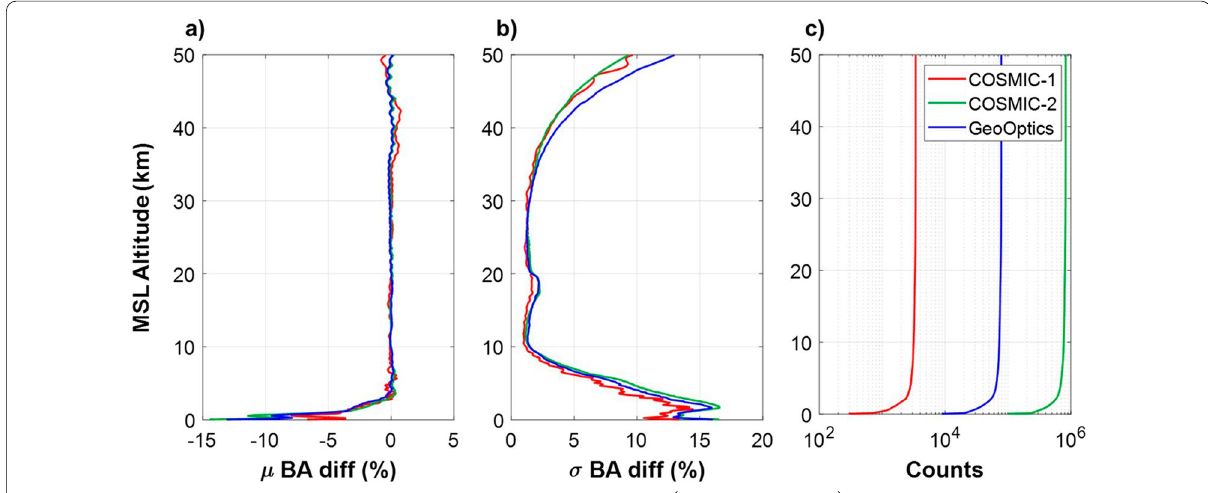
× 100 (cid:30) and c counts of ECMWF